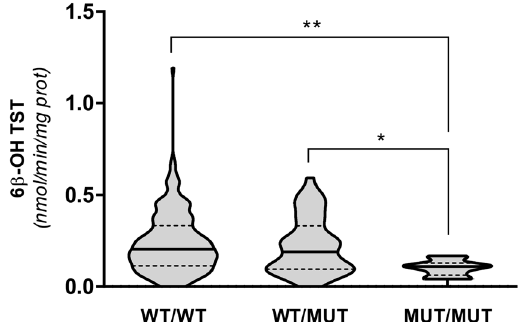
Figure 2. 6 β -OH TST production in liver microsomes isolated from Piedmontese bulls genotyped for CYP3A28_7 Gly197Ser. The catalytic activity was calculated in nmoles min − 1 mg − 1 protein. ANOVA followed by Tukey’s post-test was used for statistical analysis ( * p < 0.05; ** p < 0.01). Black and dotted lines represent median values and quartiles,